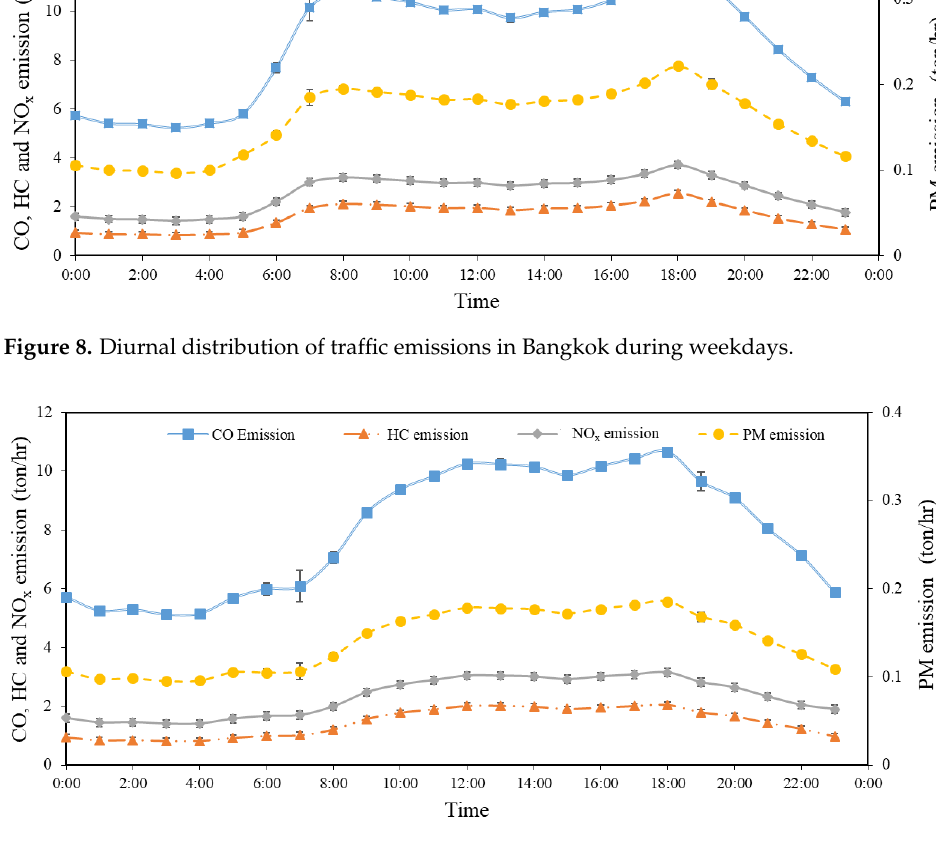
Figure 10. Spatial distribution of PM on different roads in Bangkok .